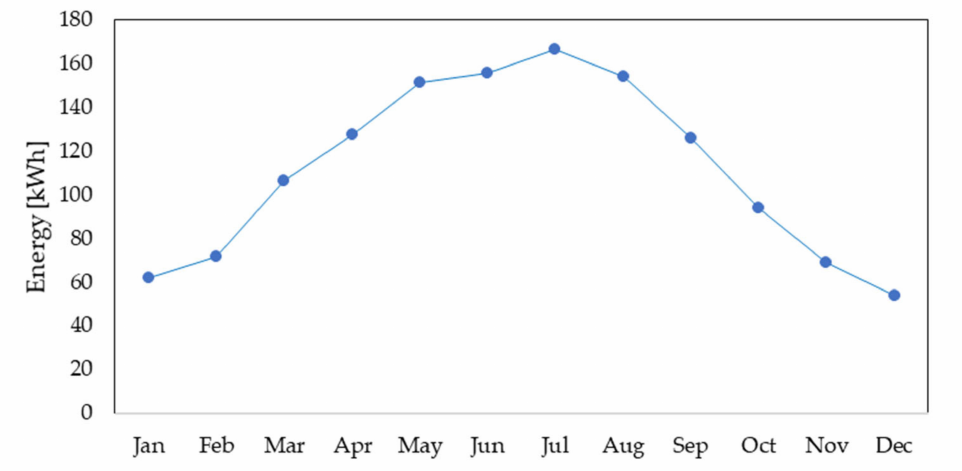
Figure 7. Total produced PV output